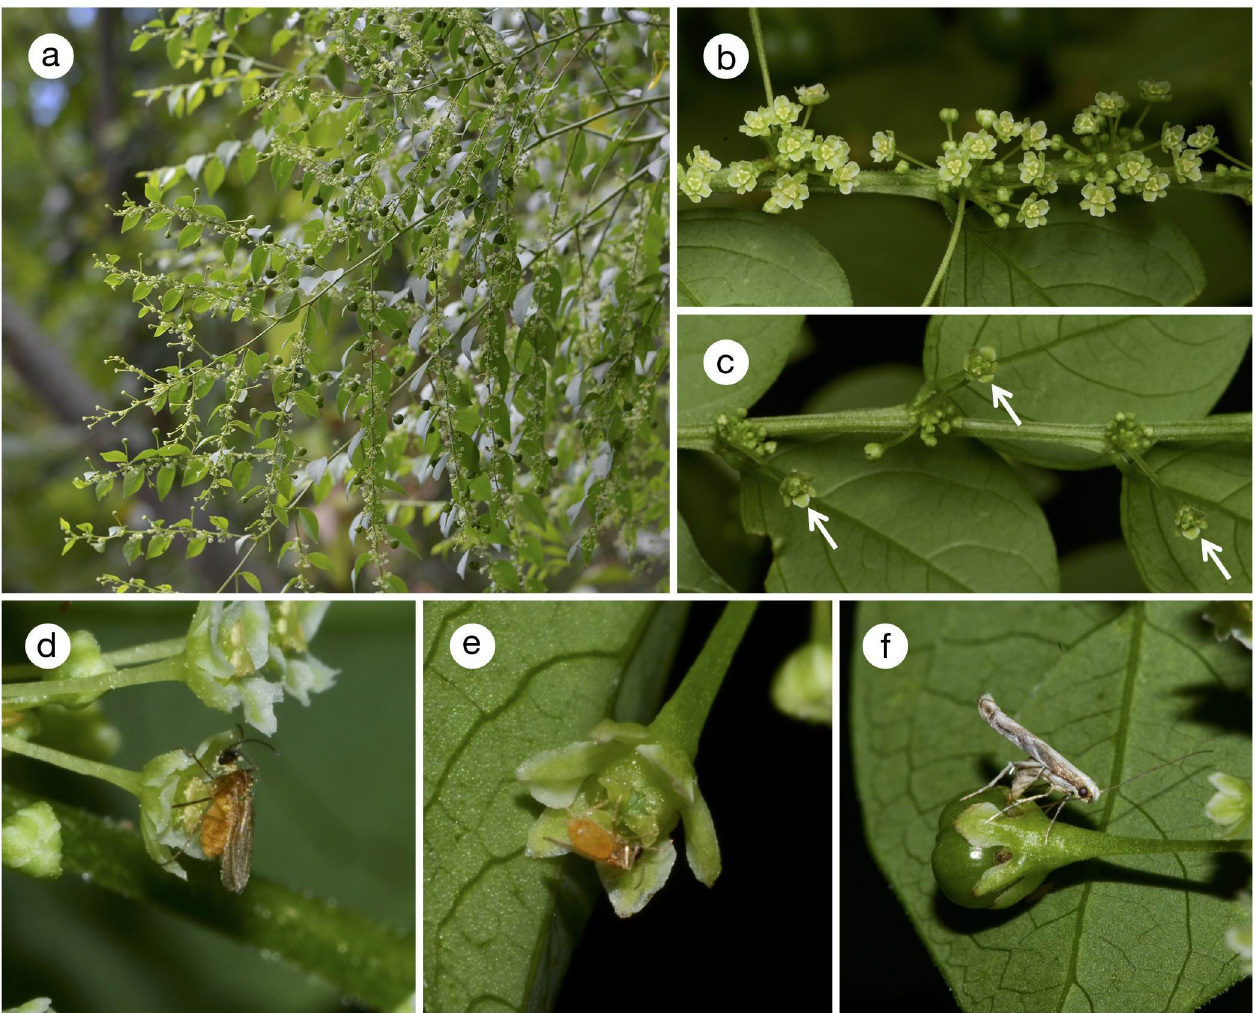
Fig 3. Phyllanthus acuminatus and associated insects. (a) Habit of P . acuminatus ; (b) male flowers; (c) female flowers (arrows); (d) male flower visited by a gall midge. Note that the head and thorax of the insect is dusted with pollen; (e) female flower visited by a gall midge, which is presumably consuming nectar; (f) an E . acuminatella female ovipositing in young